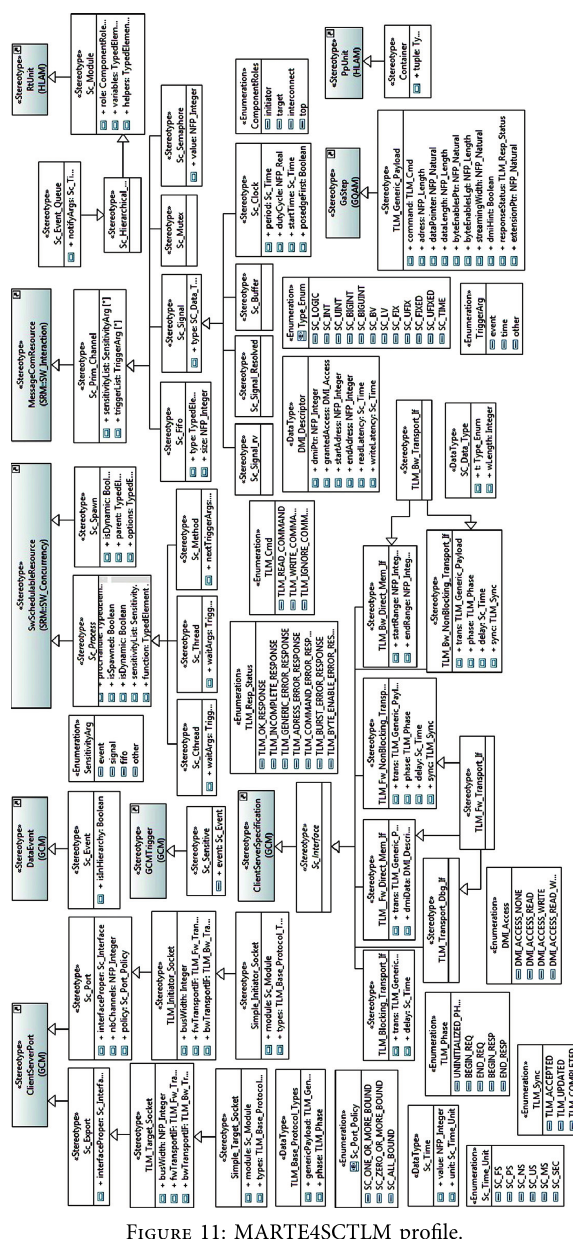
Figure 11: MARTE4SCTLM